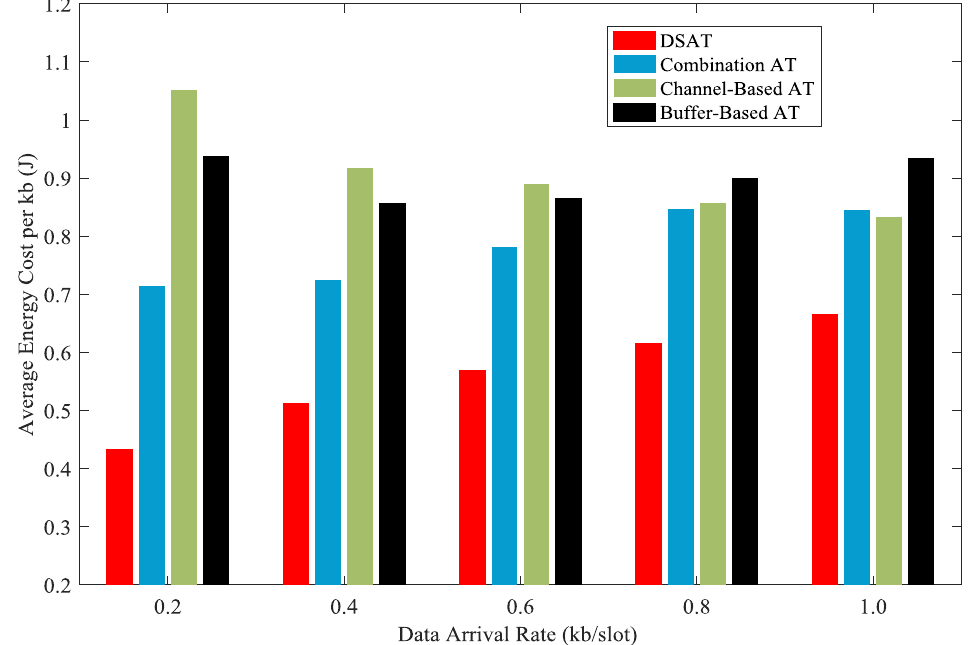
Figure 23. Average energy cost per kb of for comparative strategies (Data